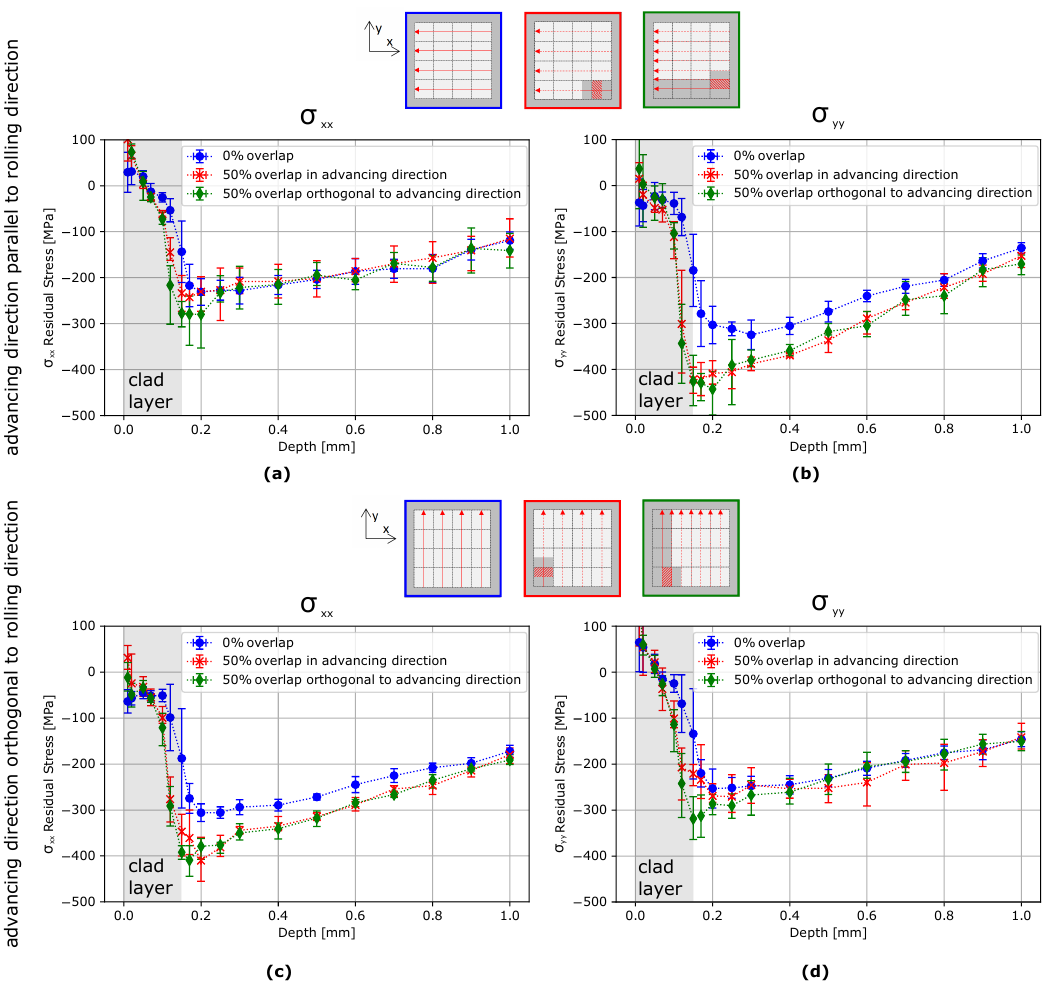
Figure 8. Residual stress profiles of AA2024-T3clad after LP for different advancing directions by varying the overlap, parallel or orthogonal to the advancing direction of the peening: No overlap, as well as 50 percent overlap are considered. Advancing direction either parallel (( a ) σ xx ; ( b ) σ yy ) or orthogonal (( c ) σ xx ; ( d ) σ yy ) to rolling direction. The gray area indicates the clad